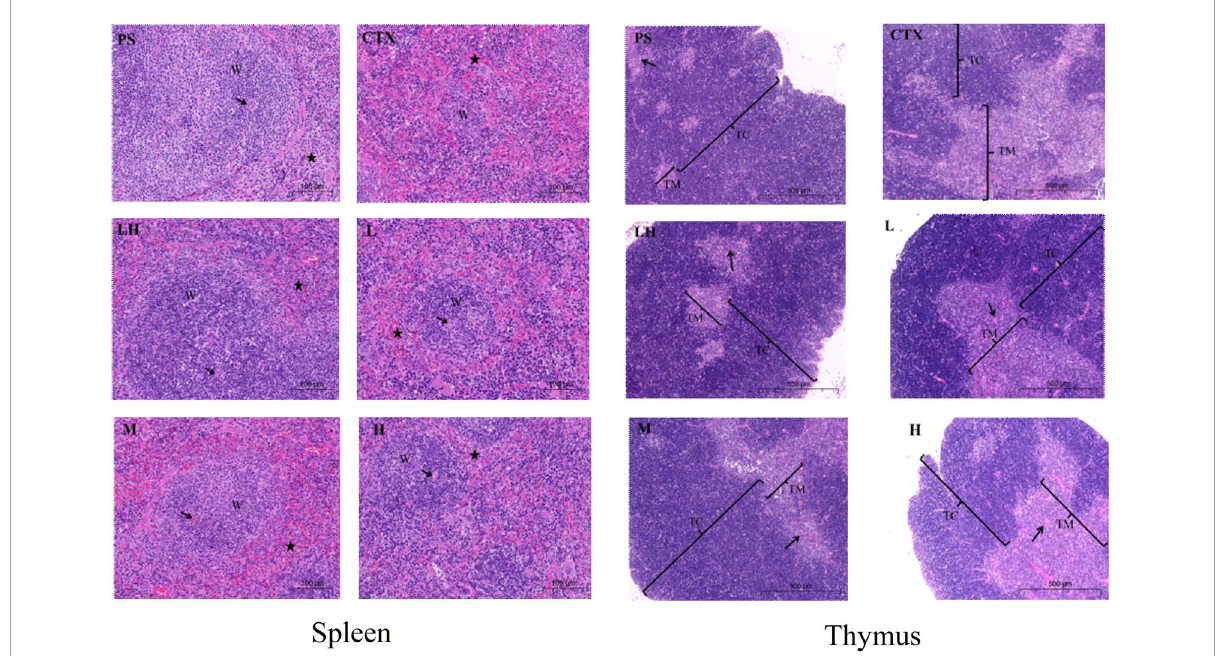
FIGURE9 Effect of SLMPs-1-1 on spleen and thymus histomorphology in mice. → Represents periarterial lymphatic sheath, W represents white pulp, (cid:63) represents red